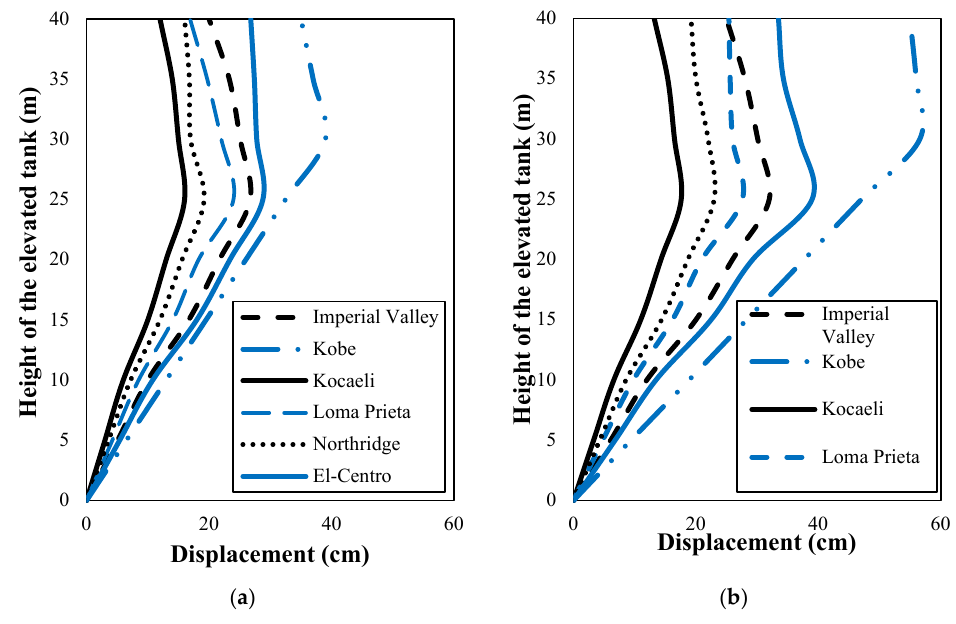
Figure 12. Differences in maximum displacement based on the filling ratio in full tanks with various elevations for ( a ) far-fault ground motions and ( b ) near-fault ground motions.